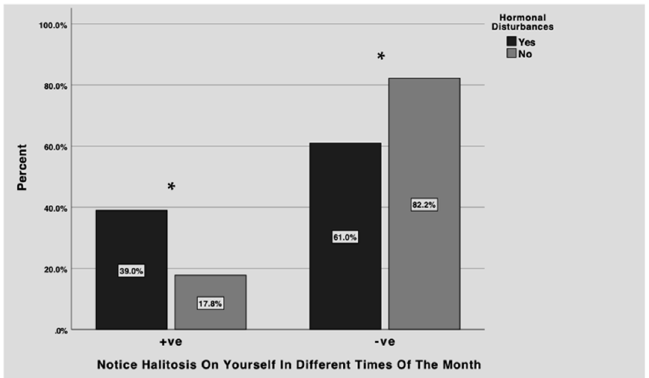
Figure 2. Noticing halitosis on oneself at different times of the month (+ve/yes or − ve/no) of participants who reported having hormonal disturbances (black) compared to participants who reported not having any hormonal disturbances (grey). More females with hormonal disturbances reported halitosis at different times of the month compared to females with no hormonal disturbances. The majority of females who reported no hormonal disturbances, do not notice halitosis on themselves at different times of the month. The results between the two groups were statistically significant (* p < 0.05).